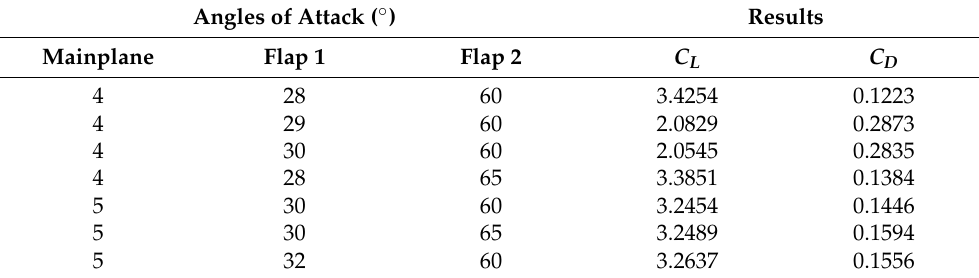
Table 2. Aerodynamic study of the angles of attack of the multi-element profile. Angles of Attack ( ◦ )